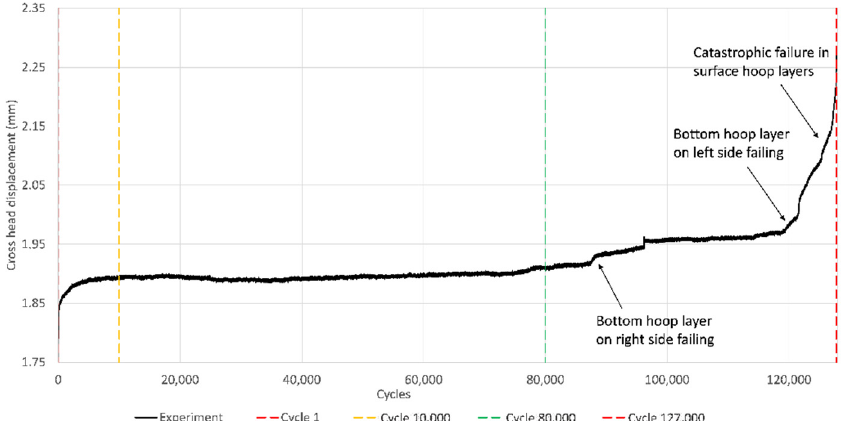
Figure 16. Cycle to displacement curve and cycle jumps.